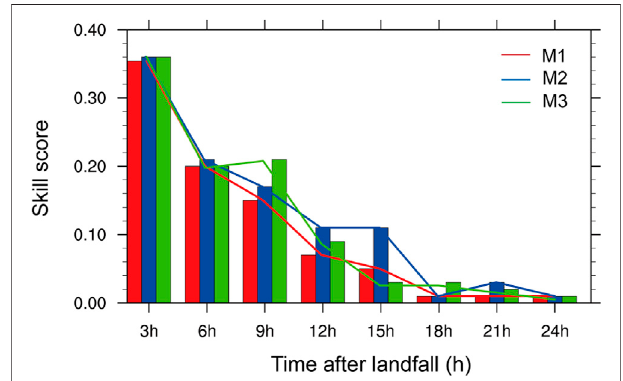
Frontiers in Earth Science |